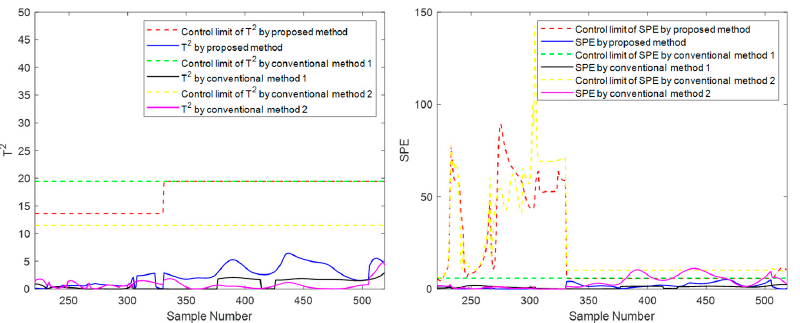
Figure 12. Online monitoring results of batch 11 by the proposed and conventional methods for the second phase.